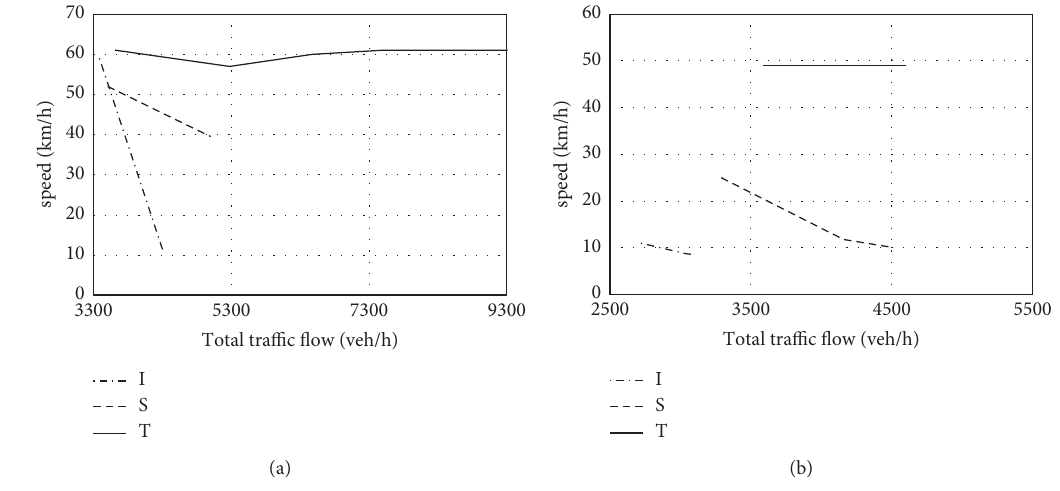
Figure 6: Bus travel speeds. (a) Unsignalized. (b)